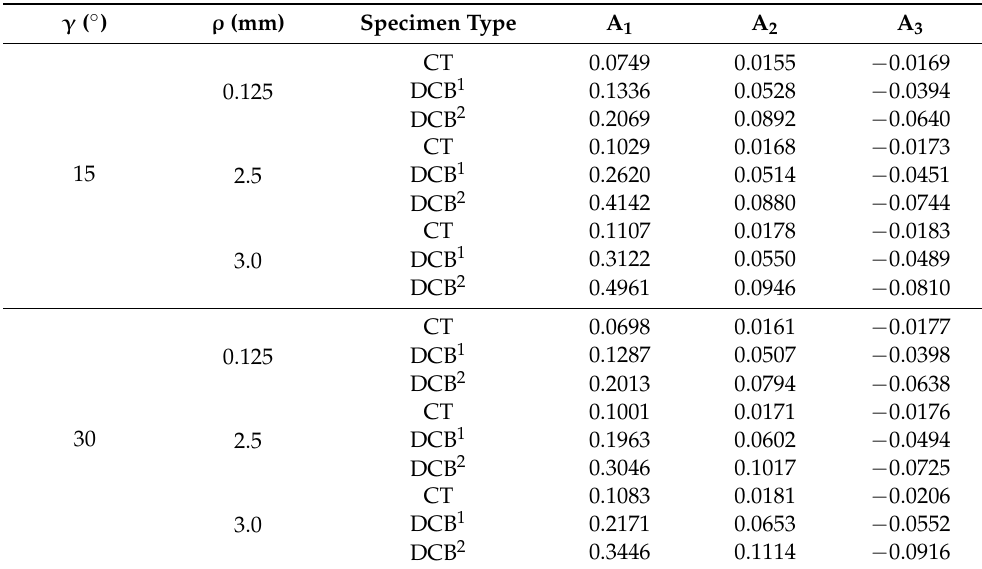
Table 3. FEOD outputs for the VO-notched specimens under the unit reference load and mode I loading